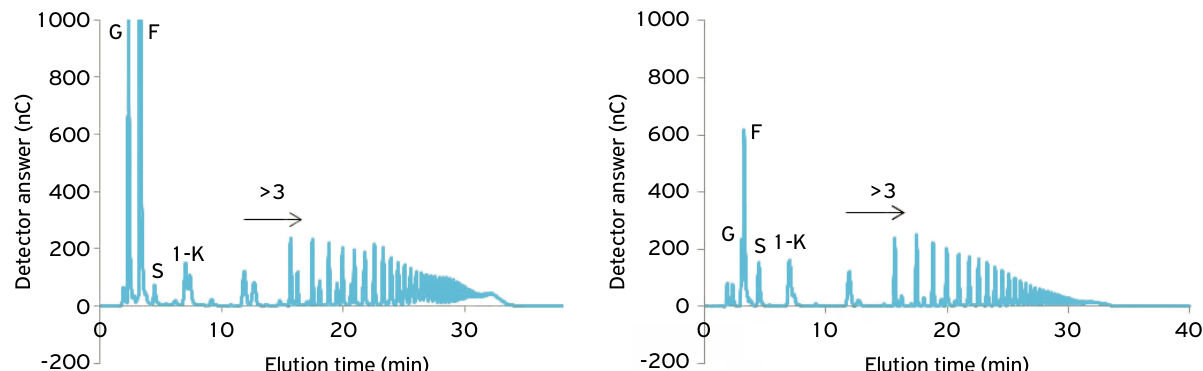
Figure 1. Analysis by HPAEC / PAD in Carbo-Pac PA1 column of the total soluble carbohydrates of Arctium lappa roots (a), oligofructans of Helianthus tuberosus as standard (b). G, F, S, 1K time of elution: glucose, fructose, sucrose and 1-cestose standards, respectively. The remaining peaks were identified by comparison with the elution time of the oligofrutans of H. tuberosus . The numerical values refer to the GP of the fructan. Samples containing 200 mg fructose /